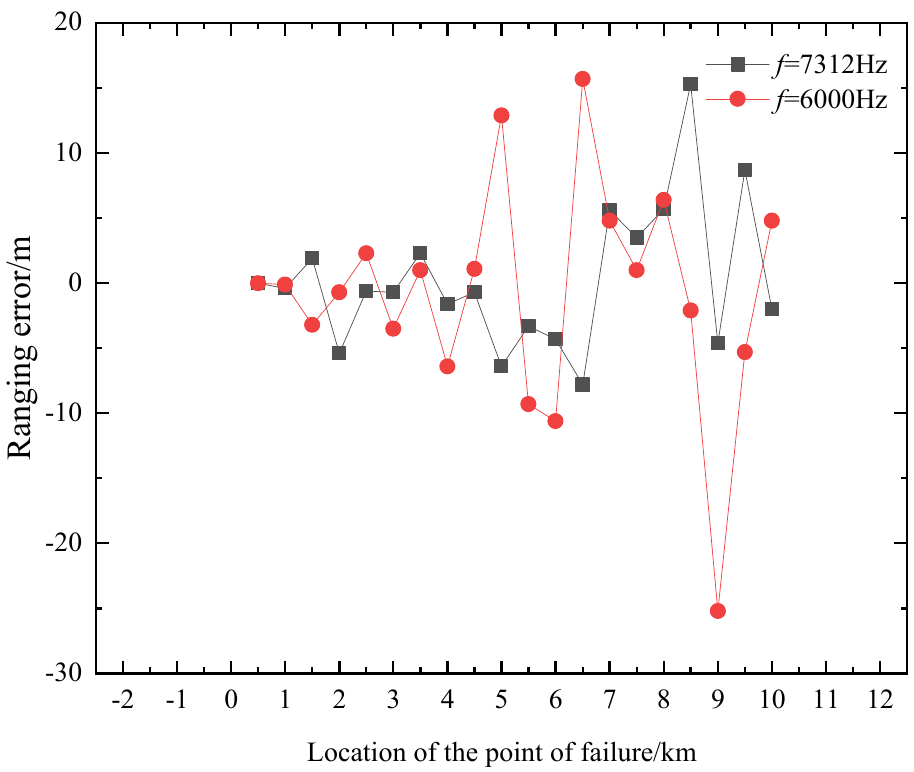
Figure 6. Distribution of lossy positioning errors at 20 fault points at different frequencies.